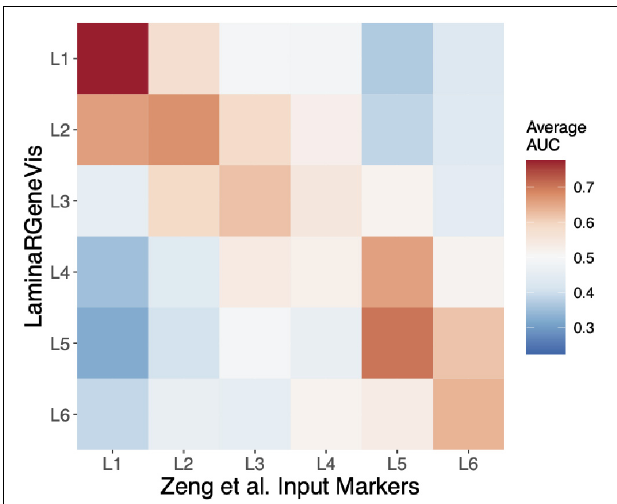
FIGURE 3 | Heatmap visualization of the LaminaRGeneVis enrichment AUC values for the laminar specific expression markers provided by Zeng and colleagues ( x -axis). Each column displays the average AUC enrichment values across the five datasets from layer 1 (L1) to 6